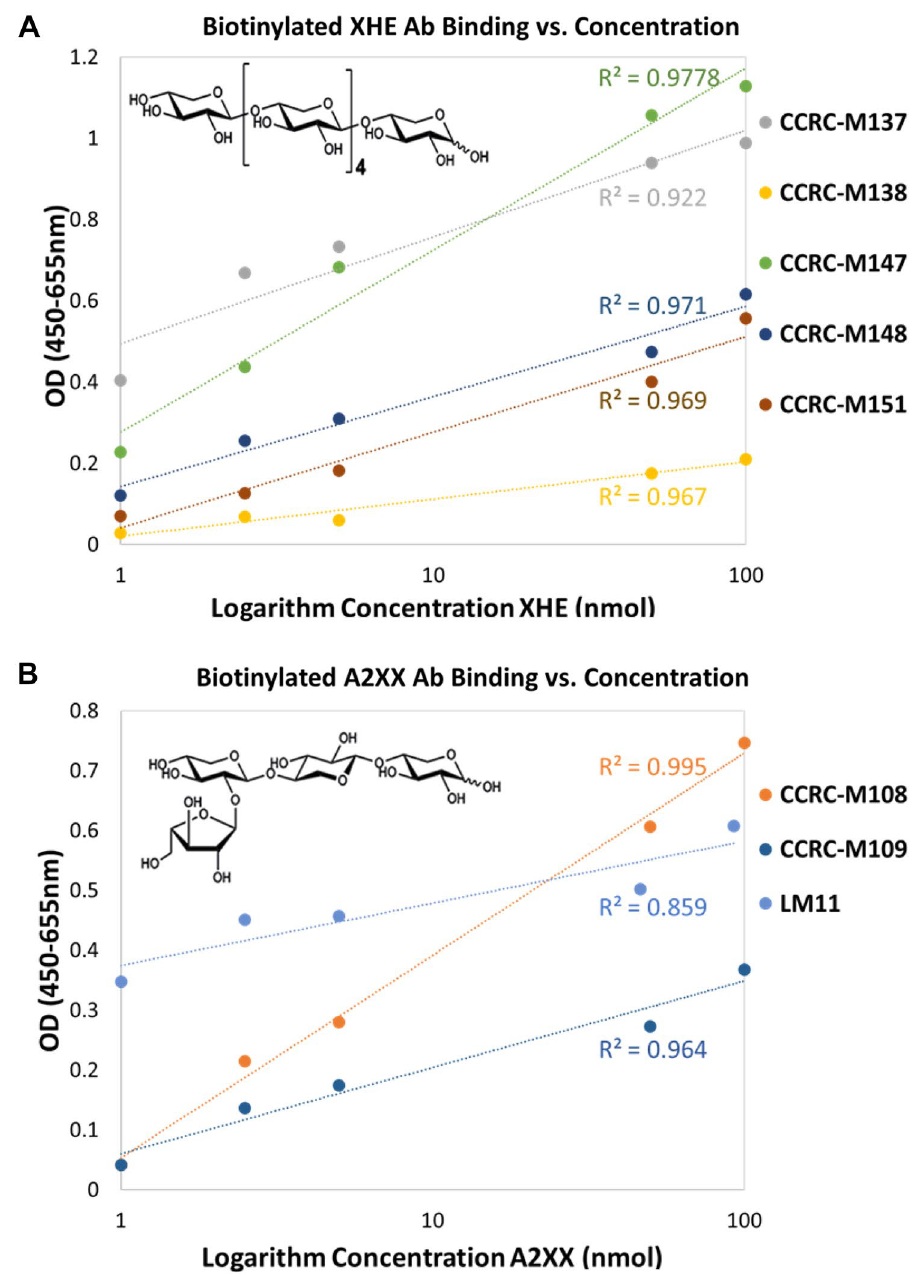
Figure 6. Two commercial oligosaccharides were used to determine the detection range of different glycan- directed monoclonal antibodies. Here, linear correlation with the logarithm concentration of oligosaccharides concentration indicated a Langmuir adsorption model for ( A ) XHE vs. mAbs and ( B ) A2XX vs. mAbs. Respective epitopes indicated the structures in the commercial oligosaccharides that were used as substrates in the